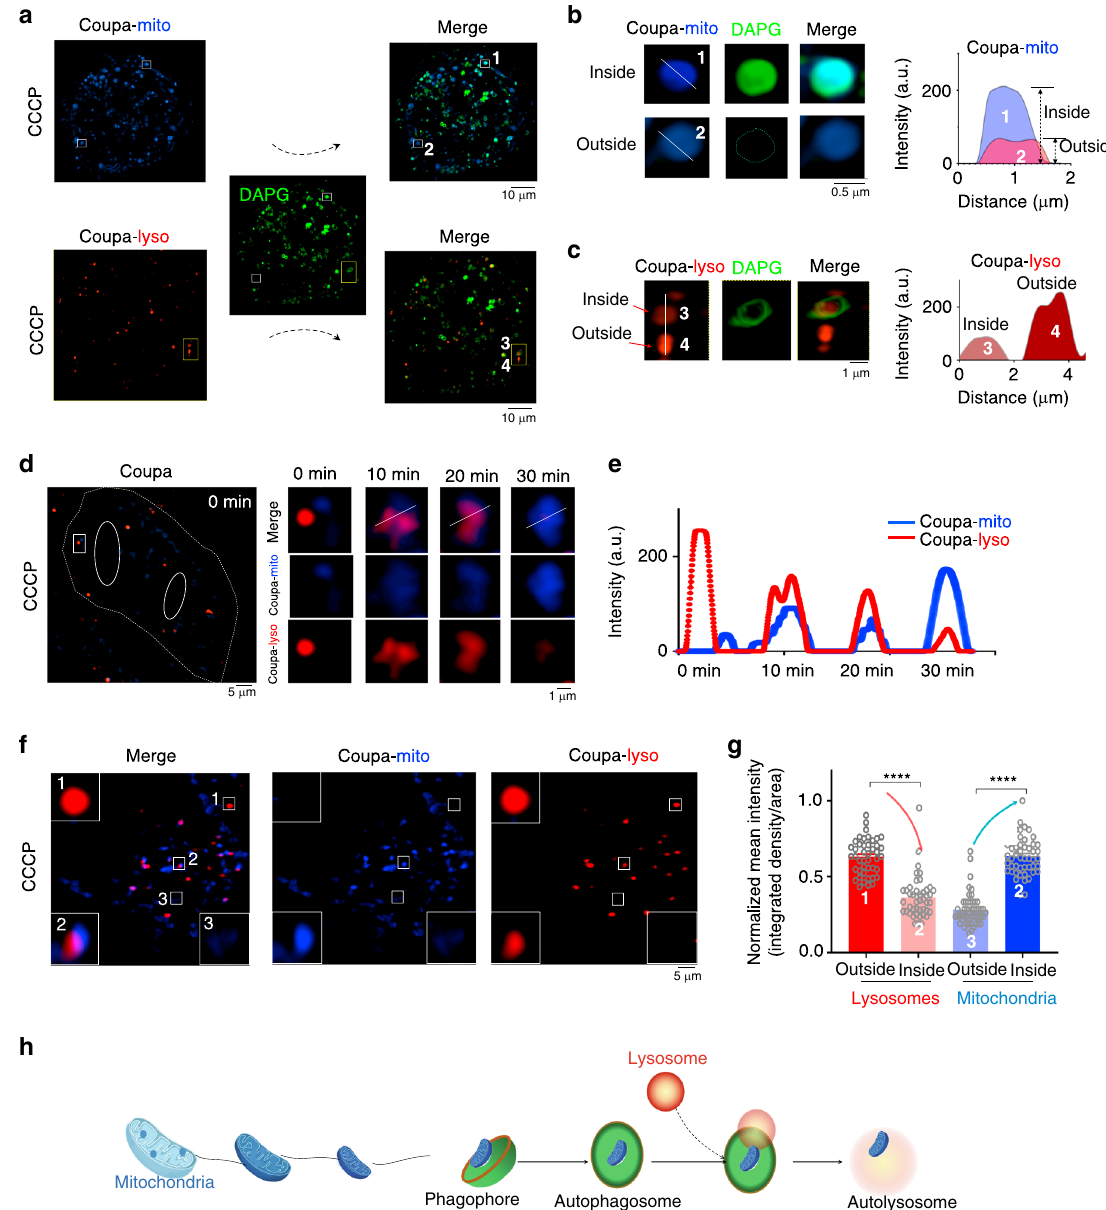
Fig. 3 Coupa monitors mitochondrion – lysosome interactions in mitophagy via SIM imaging. a Co-localization of Coupa-stained mitochondria/lysosomes and DAPG-stained autophagosomes in CCCP-treated (10 μ M, 12 h at 37 °C) HeLa cells. b Zoom-in images of regions of interest in white frames representing the mitochondria inside (1) and outside (2) the autophagosomes. c Zoom-in images of regions of interest in white frames representing the lysosomes inside (3) and outside (4) the autophagosomes. d SIM tracking of mitochondrion-lysosome interaction during mitophagy in the CCCP-treated (50 μ M) HeLa cells via Coupa staining; solid white lines in the merged images indicate where fl uorescence intensity pro fi les shown in e were measured. f SIM imaging of mitochondrion – lysosome interaction in CCCP-treated cells for 12 h; white rectangles indicate lysosomes outside autolysosomes (1), mitochondria and lysosomes inside autolysosomes (2), and mitochondria outside autolysosomes (3). g Normalized average fl uorescence intensity of mitochondrion – lysosome interactions. Data are mean ± SEM ( n = 44 particles from 10 cells for lysosomes group, and n = 49 particles from 15 cells